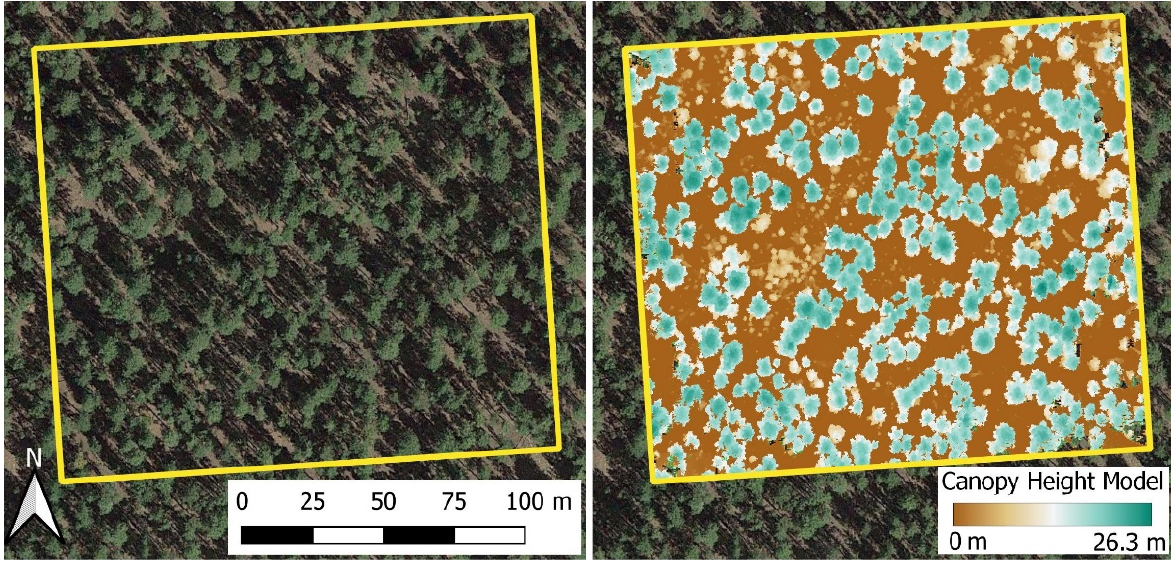
Figure 1. Study area extent is shown using UAV-derived orthophoto ( left ) and UAV-derived can- opy height model ( right ) from a structure from motion point